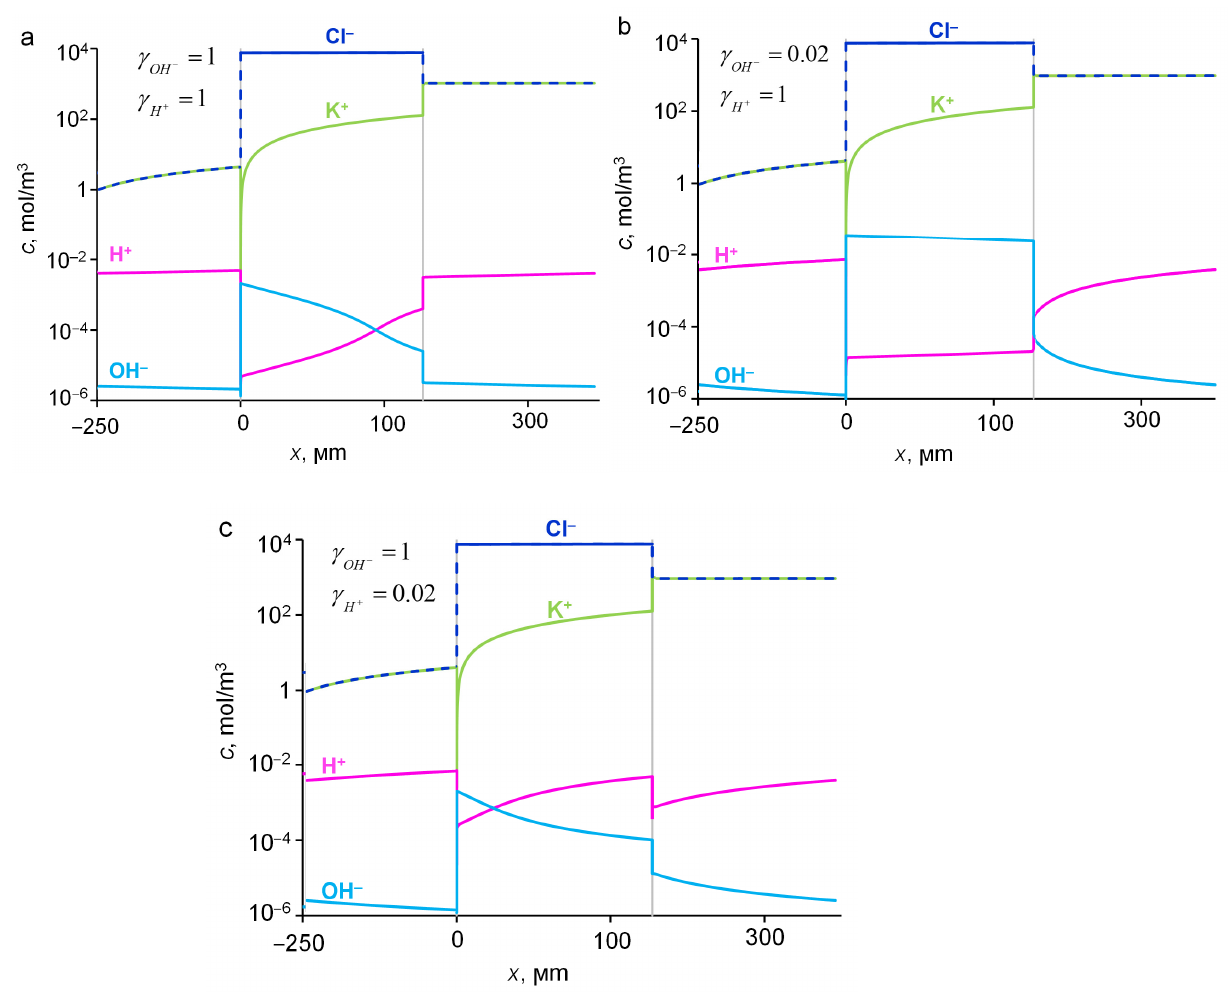
γ γ and γ − and H + OH − H + OH